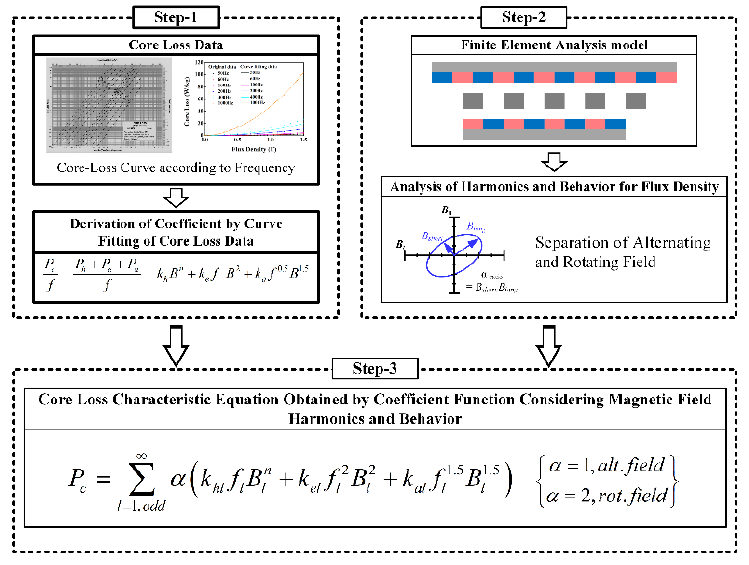
Figure 1. Proposed core-loss analysis flow chart.